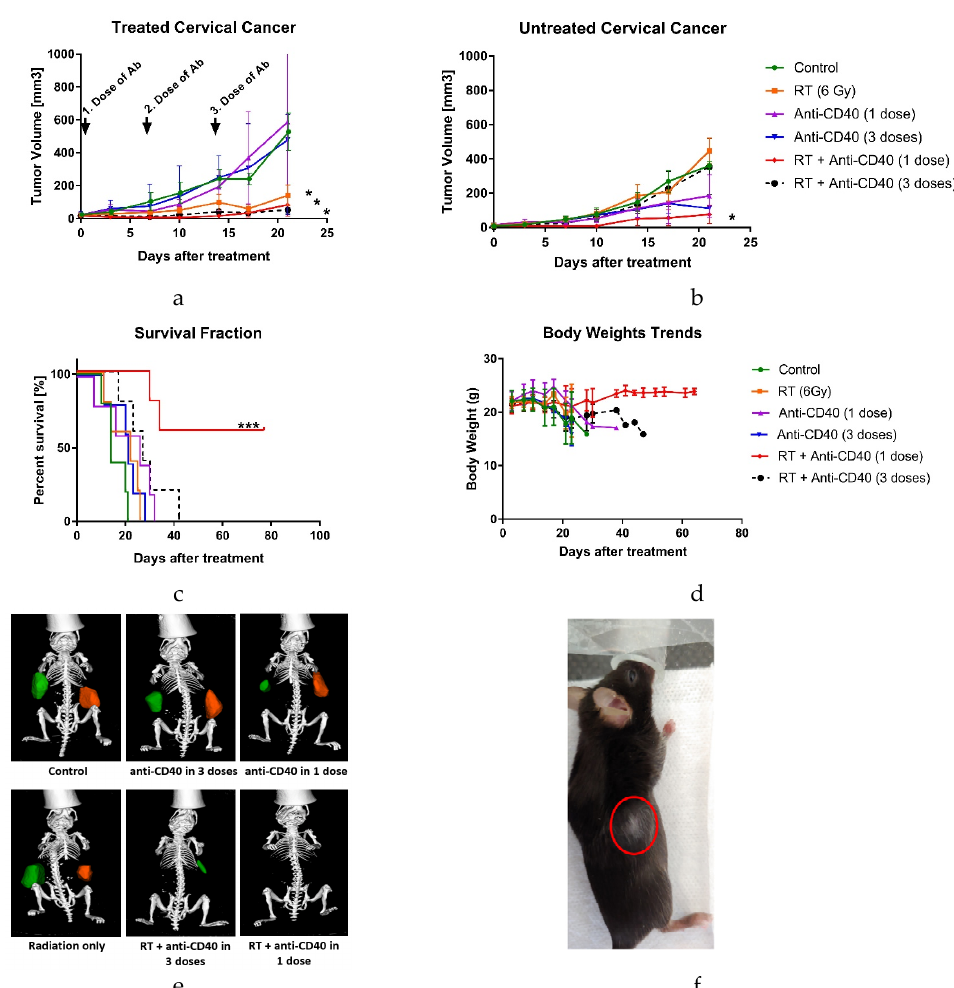
Figure 4. Immunoadjuvant dosing titration study on TC-1 tumors. Single dose of 6 Gy RT combined with anti-CD40 in single direct injection (concentration 20 µg/tumor) induced an abscopal effect,